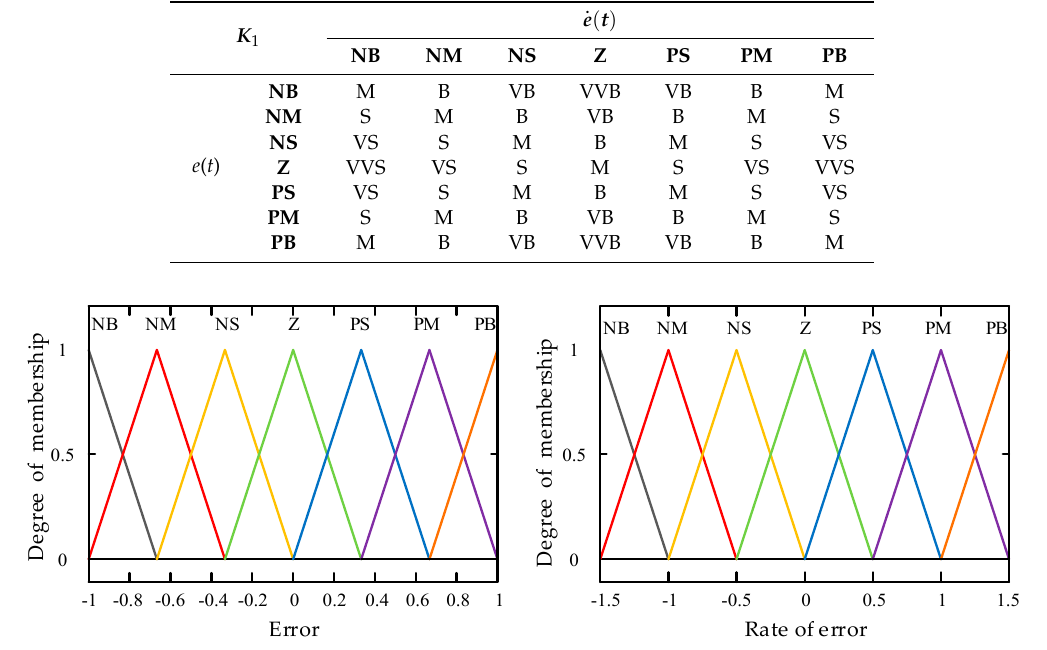
Figure 5. Membership function of the error and the rate of error.